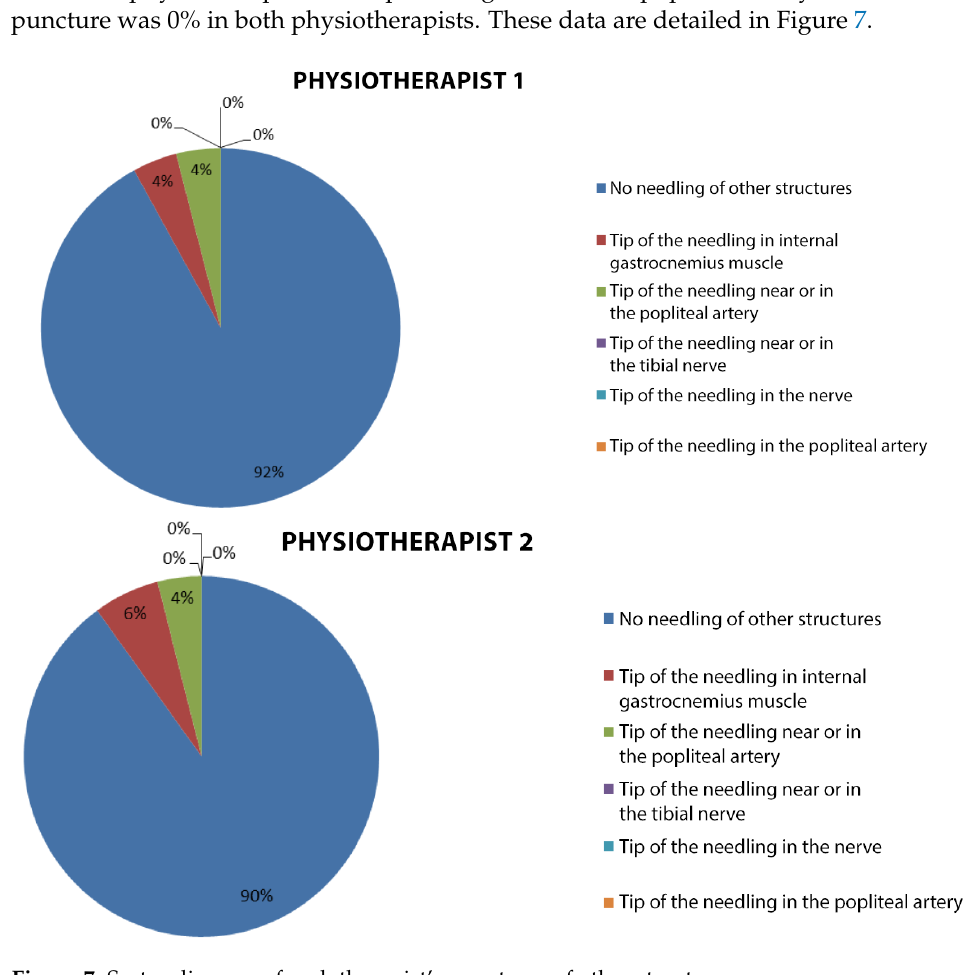
Table 5. Correlation data between the pain and muscle region for physiotherapist 1. VNS